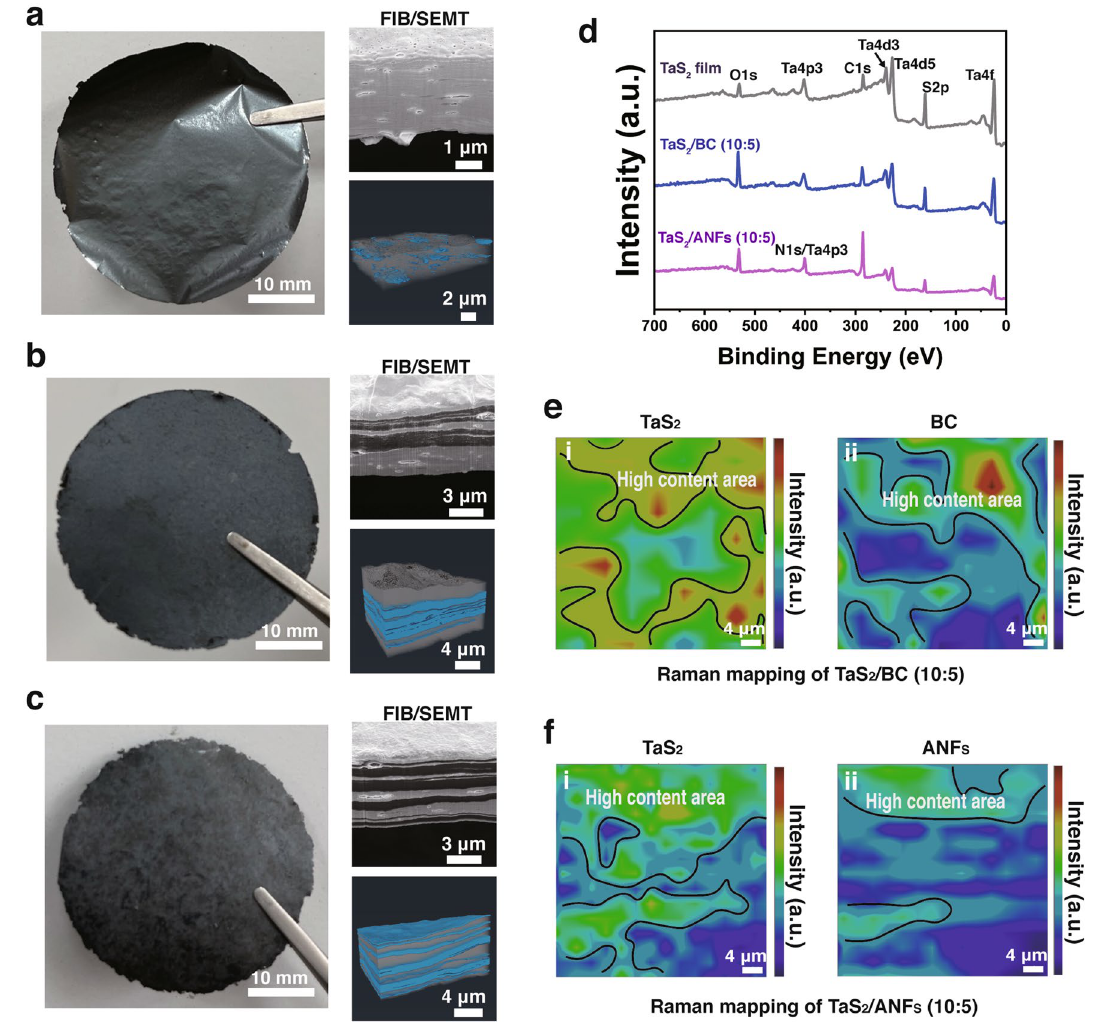
Fig. 4 Structure characterizations of TaS 2 films. Photos, cross-sectional SEM images and 3D reconstruction microstructure based on FIB/SEMT of a TaS 2 freestanding film, b TaS 2 /BC (10:1) composite film, and c TaS 2 /ANFs (10:1) composite film (Gray indicates TaS 2 , Blue indicates voids, BC or ANFs). d XPS survey spectra of TaS 2 freestanding film, TaS 2 /BC (10:5) composite film, and TaS 2 /ANFs (10:5) composite film. Raman mappings of e TaS 2 /BC (10:5) composite film and f TaS 2 /ANFs (10:5) composite